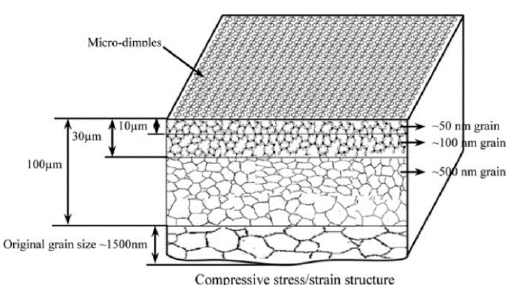
Figure 8. Schematic illustration of structure characteristics and distributions in a surface layer sub- jected to the UNSM reprinted from ref. [31]. Copyright 2022 ELSEVIER.